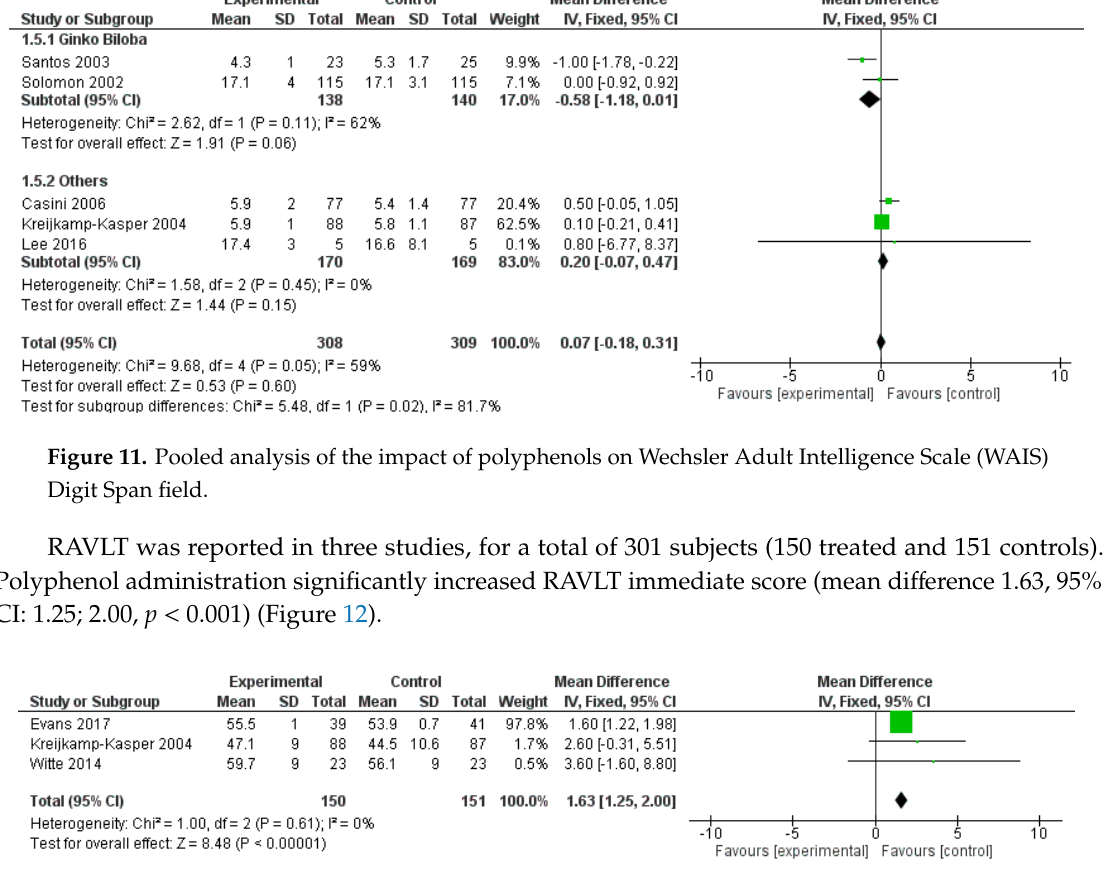
Figure 12. Pooled analysis of the impact of polyphenols on Reys Auditory Verbal Learning Task (RAVLT) .